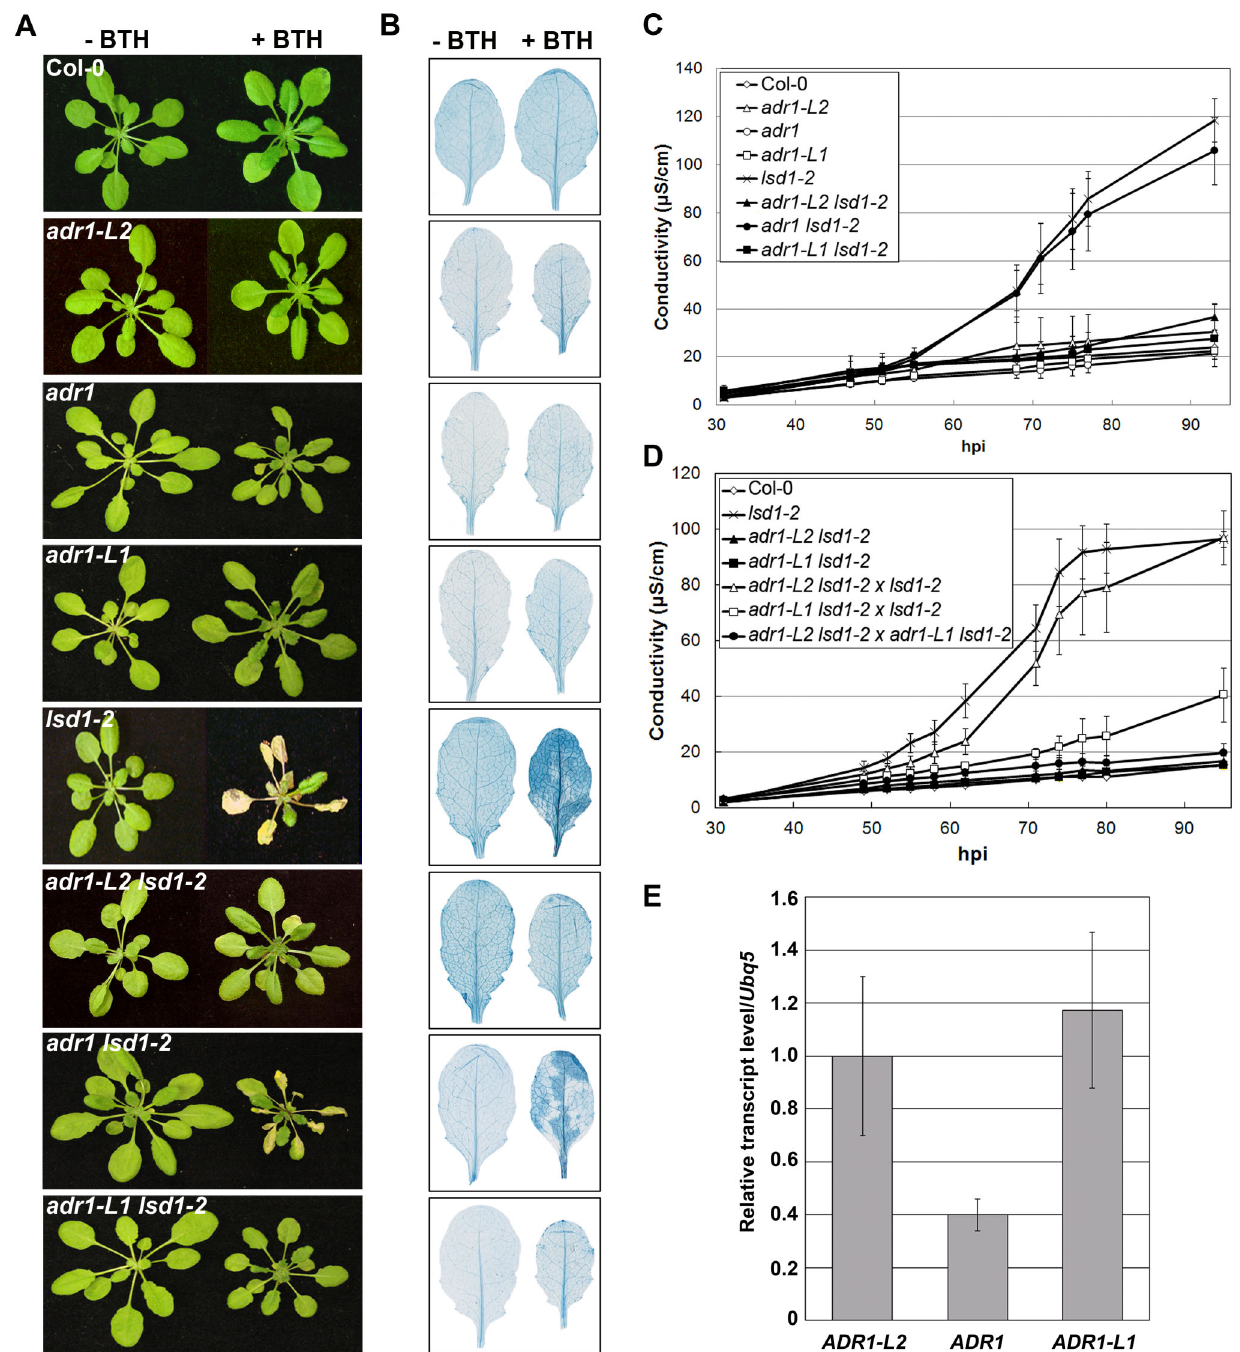
Figure 1. A family of CC-NB-LRR proteins is required for lsd1 runaway cell death. (A) Four-week-old plants were sprayed with 300 m M BTH or water. Pictures of plants were taken 5 days post-inoculation (dpi). (B) Leaves from plants in (A) were stained with trypan blue to visualize cell death. Leaves on the left are water-treated controls, leaves on the right are sprayed with 300 m M BTH. (C) Ion leakage measurements from (A), 5 days post- BTH treatment. Values are means 6 2 6 SE (n=5). (D) Ion leakage measurements for NANC. adr1-L1 lsd1-2 6 lsd1-2 , adr1-L2 lsd1-2 6 lsd1-2 , adr1-L1 lsd1- 2 6 adr1-L2 lsd1-2 represent F1 plants of the indicated crosses, and are thus lsd1 homozygous and heterozygous for the indicated adr mutations. (E) Quantitative real time PCR for the transcript amounts of the three members of the ADR family in wild-type Col-0 plants, normalized to UBQ5 .